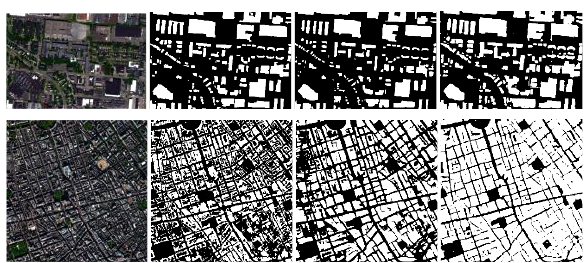
Fig. 5. Orthophoto and building segmentation map in example areas of Columbus-area-2 (upper) and London-area-1 (bottom), from left to right: orthophoto, segmentation from UNet, segmentation from HRNet, segmentation from Swin-